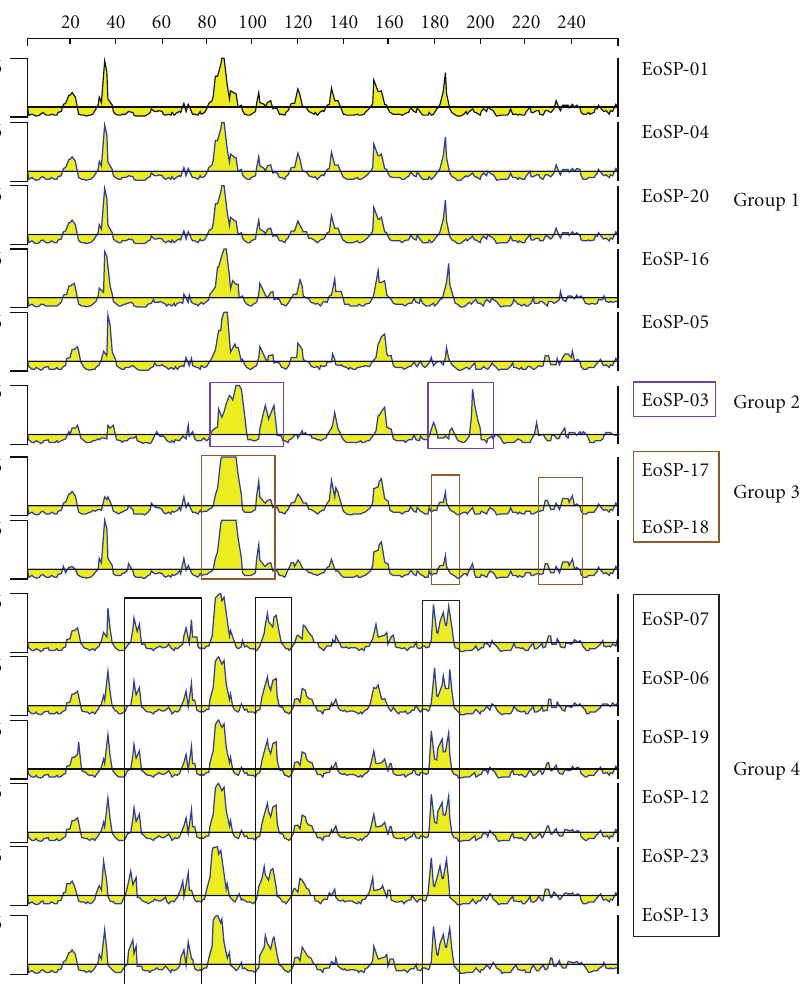
Figure 3: Di ff erentiation of the fourteen cDNA-encoding E. ocellatus venom gland serine proteases . The predicted surface probabilities (Emin algorithm, DNASTAR, USA) of the 14 E. ocellatus serine protease cDNAs were aligned. The boxed areas indicate group specific structural motifs.